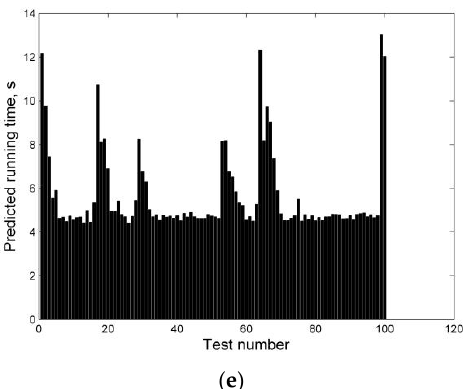
Figure 10. Running time tests for the σ skip numerical search algorithm. ( a ) Each motion state calculated time test, ( b ) Each ˆ σ skip given calculated time test from initial re-entry state, ( c ) Each ˆ σ skip given calculated time test from skip re-entry state, ( d ) σ skip searching calculated time test from initial re-entry state, and ( e ) σ skip searching calculated time test from skip re-entry state.